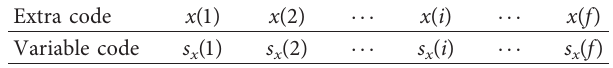
Table 1: Dual-structure coding method.